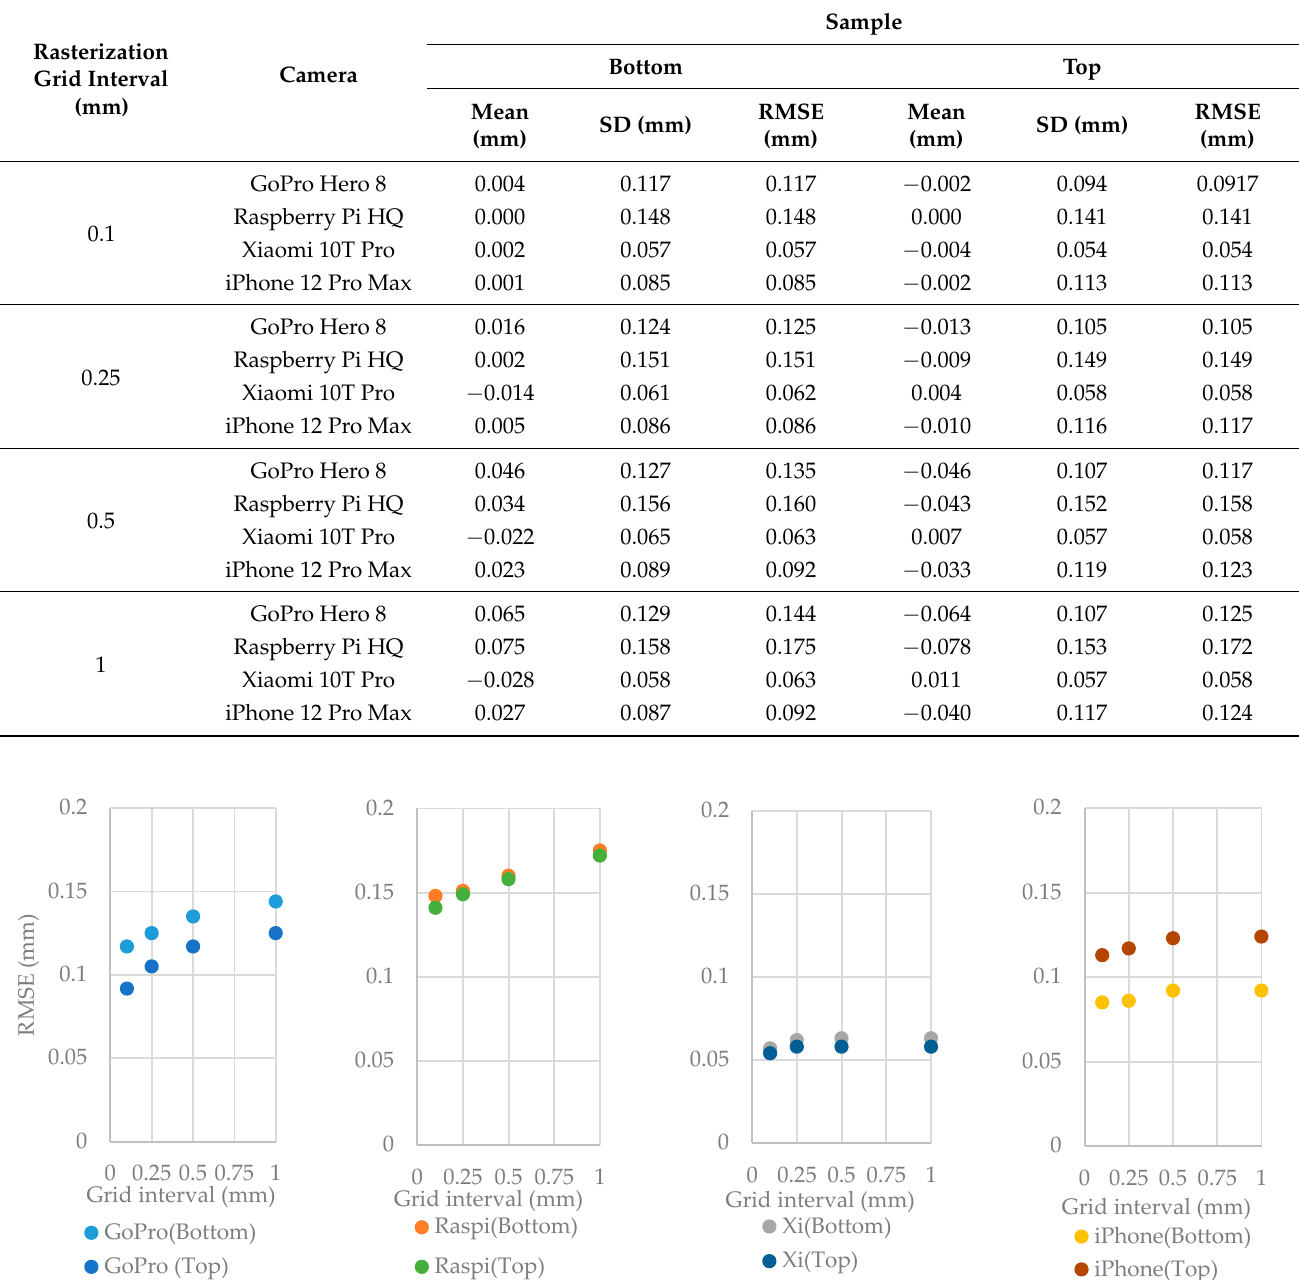
Table 6. Comparison of cloud-to-cloud distance of low-cost camera point clouds in relation to the Canon EOS 5DS R DSLR point cloud.